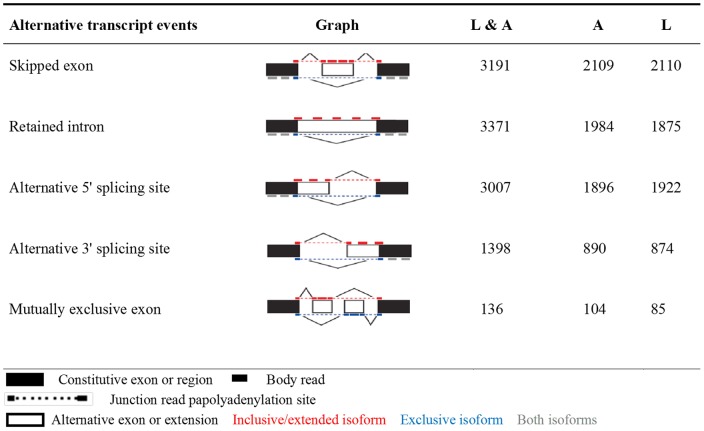
Statistics of mainly alternative splicing events.The first column shows the types of alternative transcript events; the second column shows the splicing graphs and the third to fifth column shows the number of AS events in A and L combined group, A group and L group, respectively.